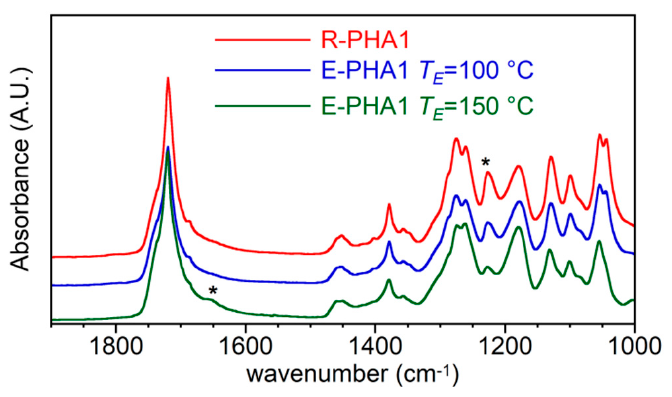
Figure 5. FTIR spectra of R-PHA1 and E-PHA1 extracted with AE at 100 °C and 150